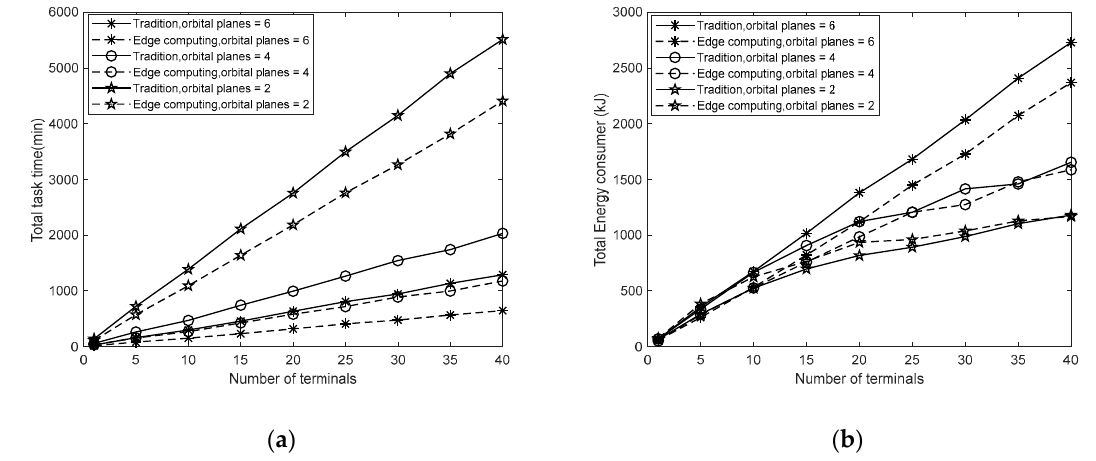
Figure 6. ( a ) the total time spent in terms of the number of terminals; ( b ) the total energy consumption in terms of the number of terminals.